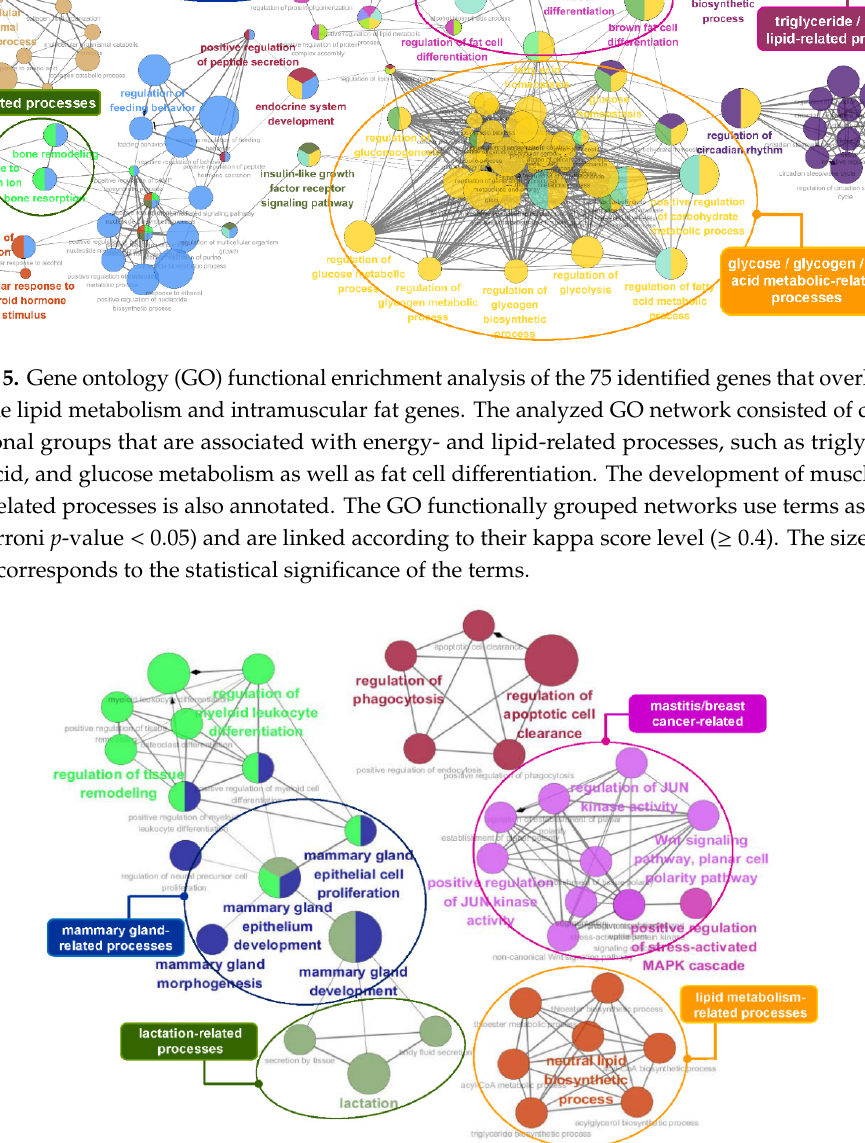
Figure 6. GO functional enrichment analysis of the 90 identified genes that overlapped with the mammary gland/milk production-related genes. This GO network comprised distinct functional groups that are implicated in mammary gland- and lactation-related processes. Moreover, several functional groups, such as Wnt signaling, the MAPK cascade, and JUN kinase activity, are associated with mastitis and breast cancer. GO functionally grouped networks use terms as nodes (Bonferroni p -value < 0.05) and are linked according to their kappa score level ( ≥ 0.4). The size of the nodes corresponds to the statistical significance of the terms.